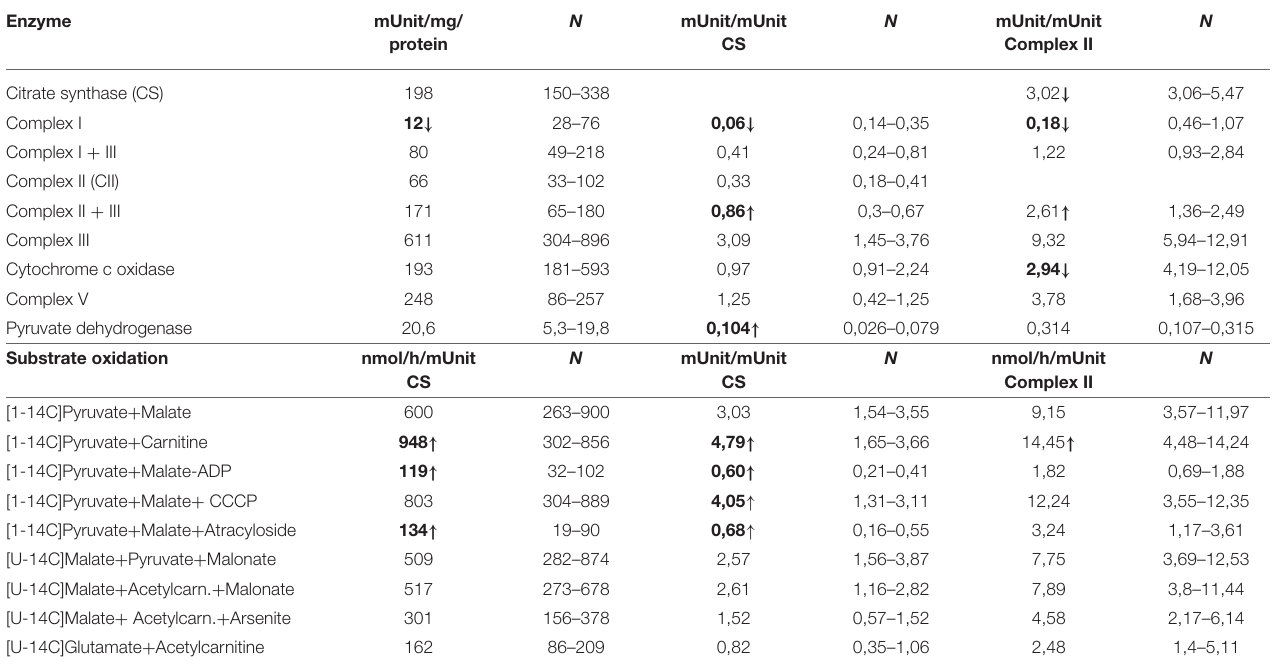
TABLE 1 | OXPHOS enzymes activity measurements and substrate oxidation in muscle of the reported patient with VARS2 deficiency. Enzyme mUnit/mg/ protein